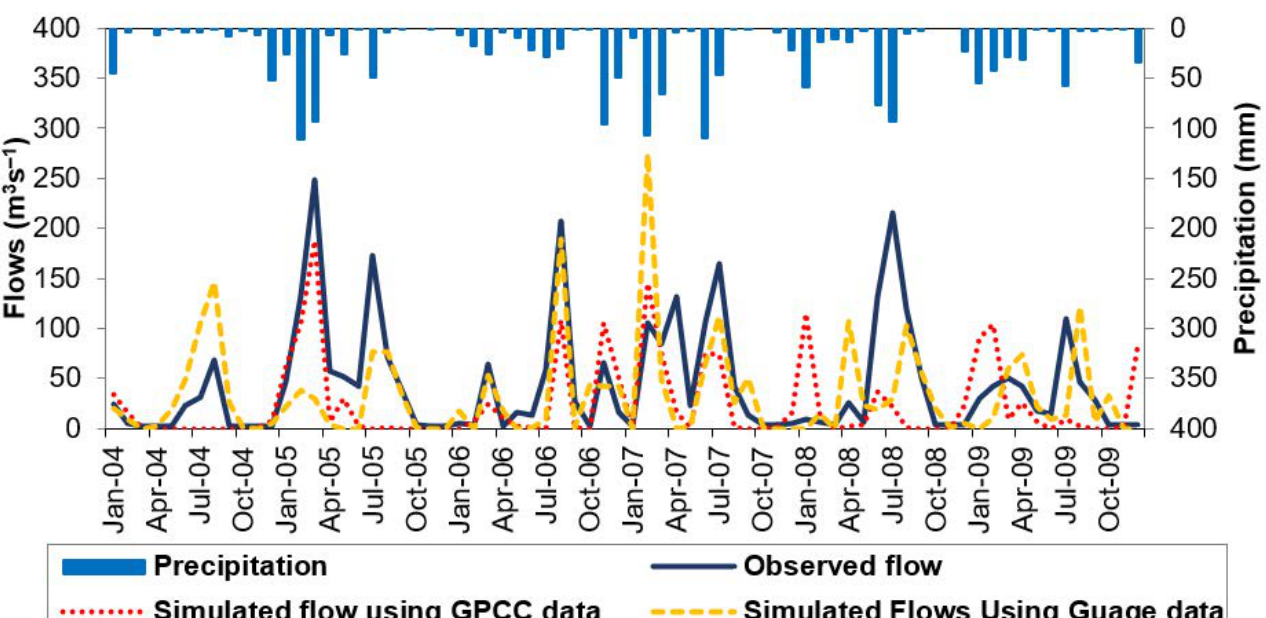
Figure 5. Simulated and observed hydrograph on monthly basis using GPCC